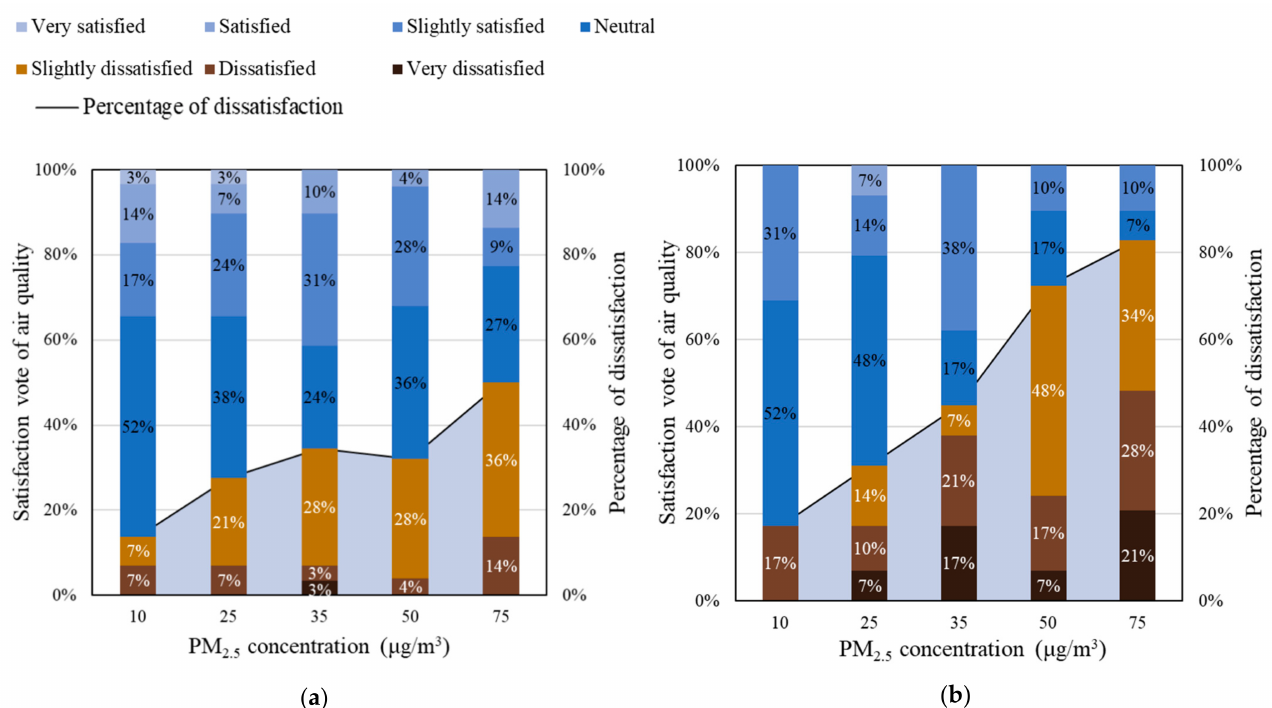
Figure 5. Distribution of satisfaction vote and percentage of dissatisfaction on air quality under different CO 2 concentration: